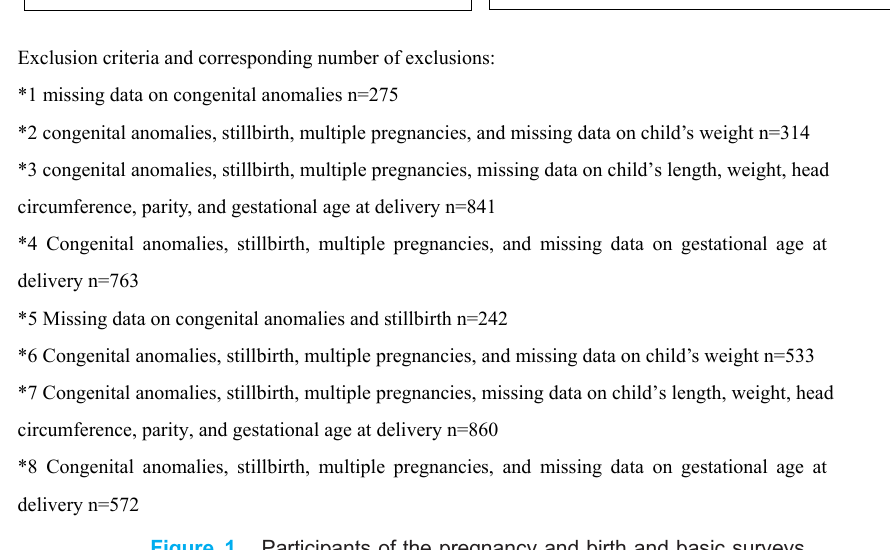
Figure 1. Participants of the pregnancy and birth and basic